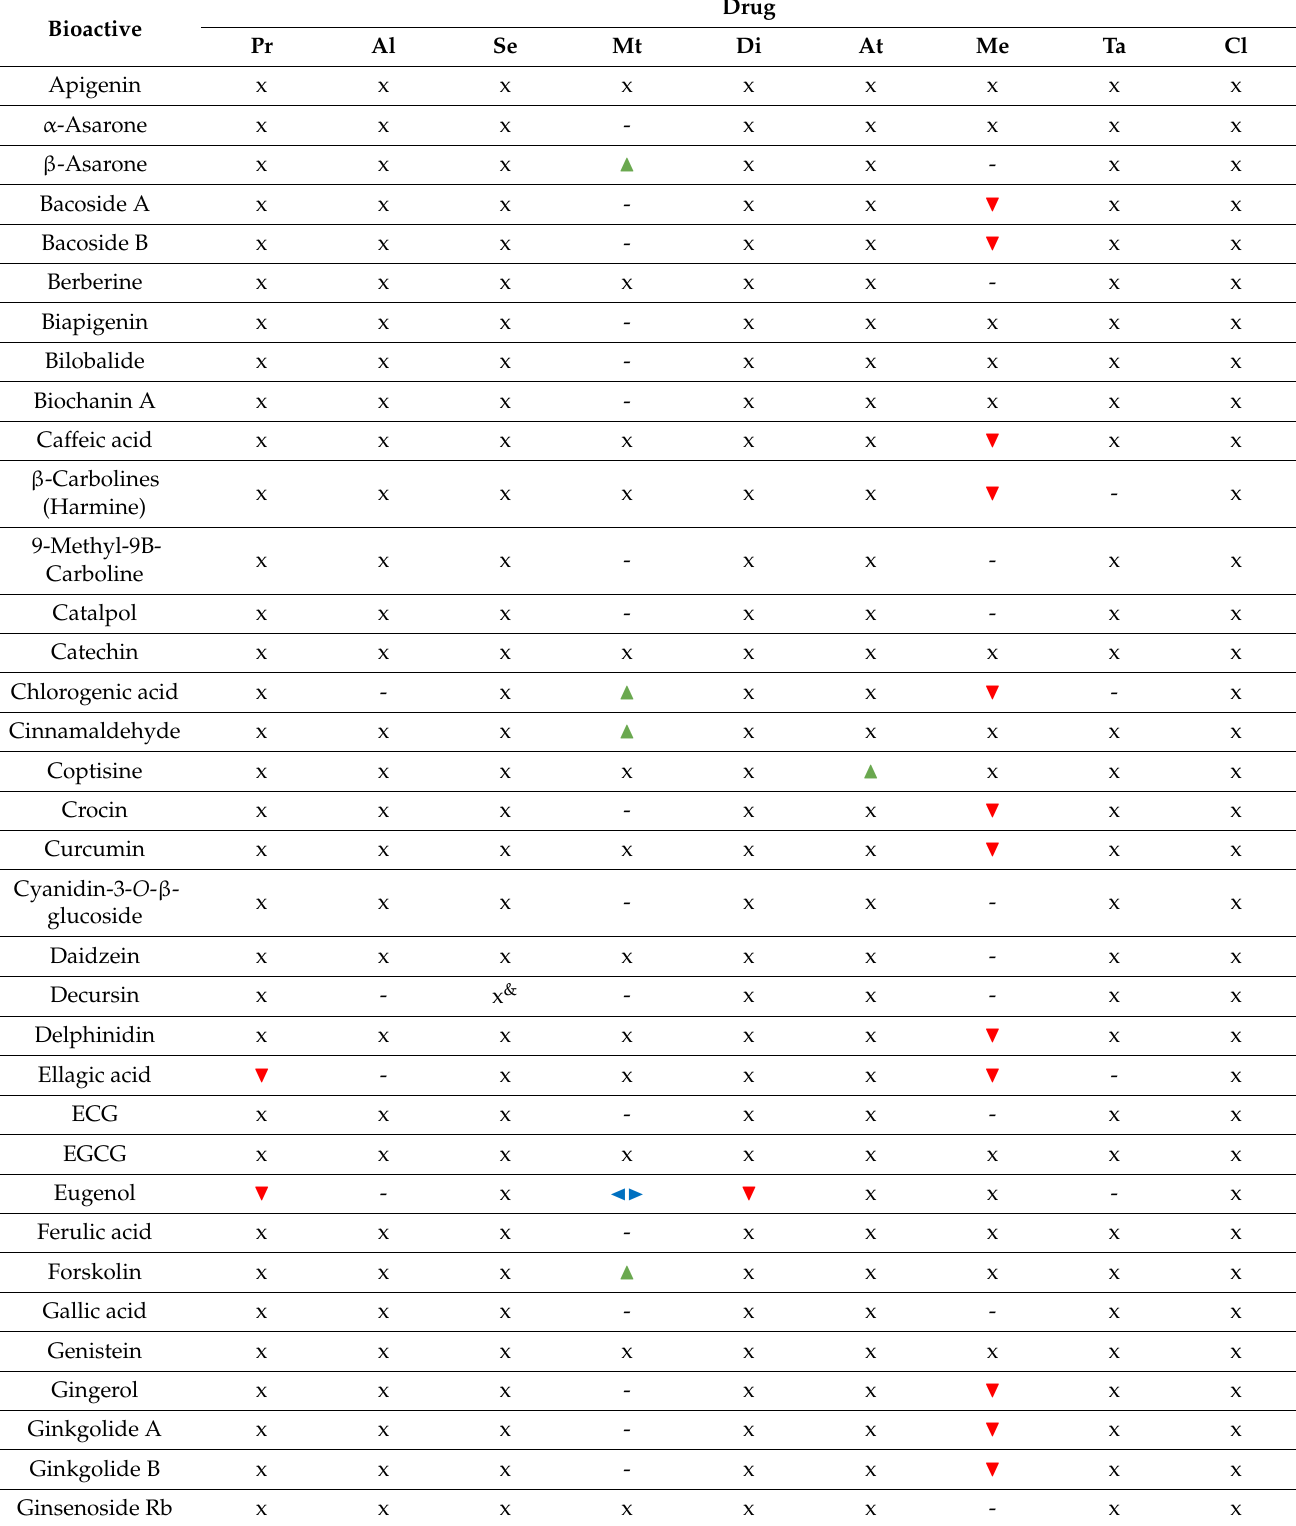
Table 4. Hypothesized interactions between selected bioactives (those inducing/inhibiting at least four of the 55 targets studied) and drugs. Interaction was considered if at least one target was simultaneously affected by bioactive and drug, while sequentially fulfilling criteria 1 and 2 (see text for details). Piracetam is not shown, since it does not interact with any of the bioactives under